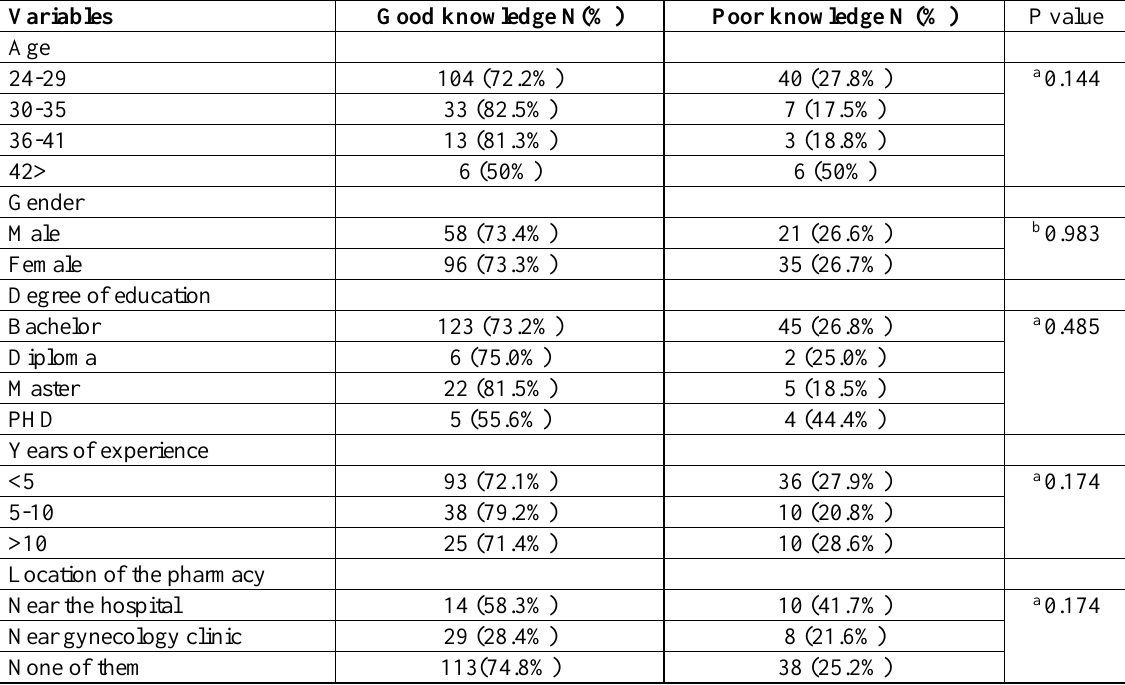
Table 3. Association between sociodemographic characteristics and community pharmacists’ knowledge